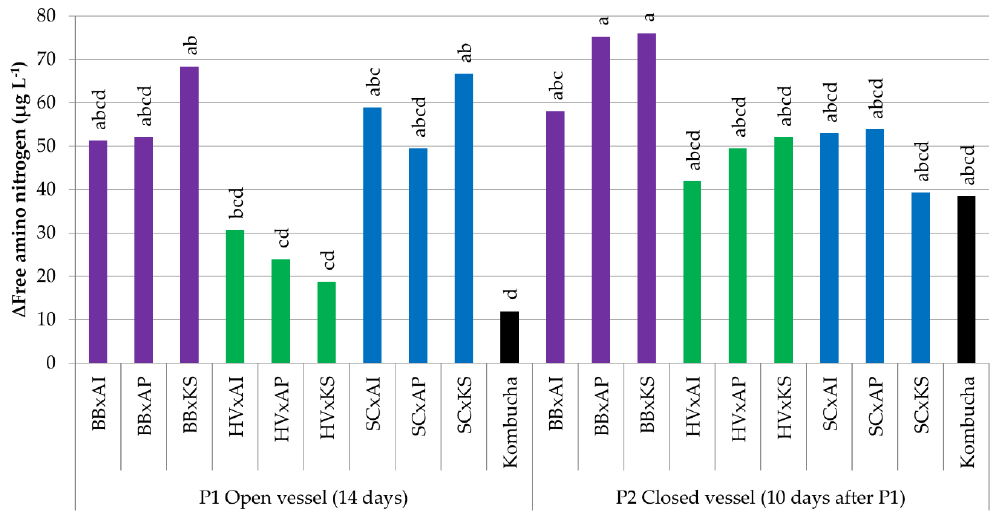
Figure 6. Di ff erence in free amino nitrogen ( µ g L − 1 ) of samples between day 0 (after inoculation) and the end point (14 days for pure cultures, 14 days in an open vessel for P1, and 10 days in a closed vessel for P2 following P1). ANOVA was performed with α = 0.05 and n = 3. Common letters imply non-significant di ff erences between means. Colors reflect the yeast species in the coculture. BB = Brettanomyces bruxellensis (purple), HV = Hanseniaspora valbyensis (green), SC = Saccharomyces cerevisiae (blue), AI = Acetobacter indonesiensis , AP = Acetobacter papayae , KS = Komagataeibacter saccharivorans , and “x” = a coculture.